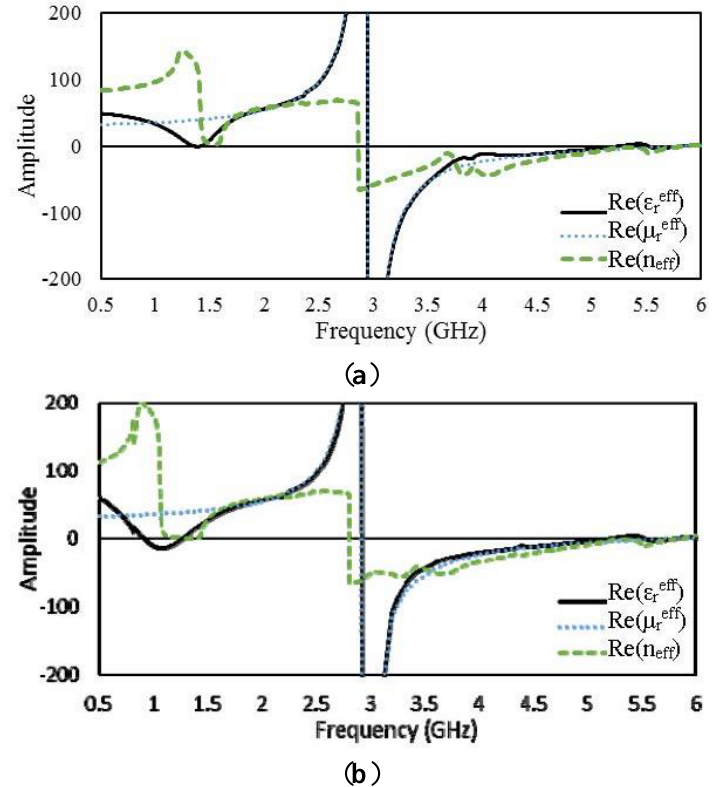
Figure 8. Real parts of the effective parameters of 2 × 2 arrays of unit cell B: ( a ) open array and ( b ) interconnected array.